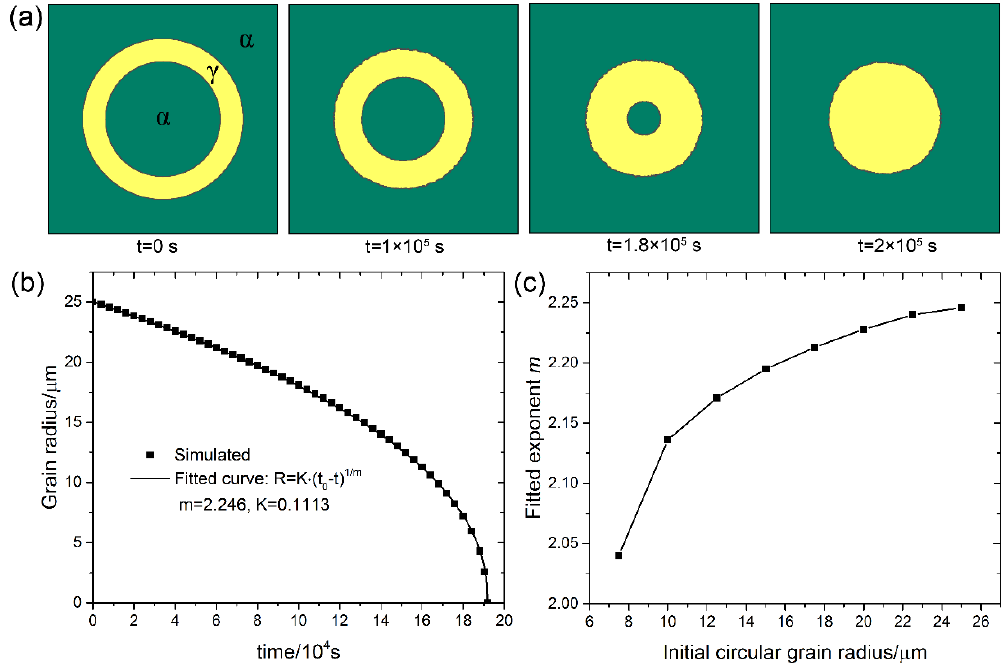
Figure 1. A typical two-phase system with circular γ phase embedded in the α matrix. ( a ) Microstructure evolution with time; ( b ) The inner grain radius vs. time; ( c ) Fitted exponent m of the function R = K ( t 0 − t ) 1/ m for different initial radii of the inner grain. Simulation grid is 1000 × 1000 with the cell size of 0.1 µ